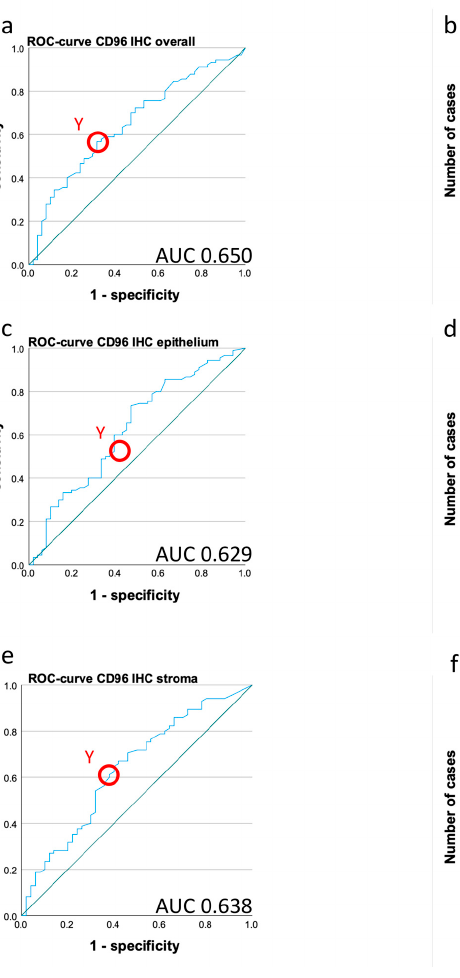
Figure 4. Determination of a cut-off point and allocation of individual cases to a group (controls vs. OSCC patients) based on CD96 protein expression. ( a , c , e ) ROC curves for CD96 mRNA protein expression based on LI determined by immunohistochemistry (IHC). The diagrams are a plot of the sensitivity (true-positive rate) vs. 1-specificity (false-positive rate) over all possible labeling indices. The circles show the points of the highest Youden (Y) indices which are associated with the COP (patients vs. controls). The AUC value is indicated. ROC: receiver operating characteristic, COP: cut-off point, AUC: area under the curve. ( b , d , f ) Division of the test and control group (group OSCC patients and group controls) into positive and negative subgroups based on the ascertained COPs of CD96 expressed as labeling index values. Using the χ 2 test, the specimens were positively (malignant) judged if the values lay above the COP. Increased CD96 expression levels in the tissue of OSCC patients ( d , f ) compared to the healthy oral mucosa of volunteers were significant. Therefore, the COP may be a parameter allowing the allocation of the tissue sample to a group and an indication of malignancy. ( a ) ROC curve for CD96 in the complete tissue area (epithelial + stromal). ( b ) χ 2 test for CD96 protein expression in the complete tissue area (epithelial + stromal). ( c ) ROC curve for CD96 in the epithelial tissue compartment. ( d ) χ 2 test for CD96 protein expression in the epithelial tissue compartment. ( e ) OC curve for CD96 in the stromal tissue compartment. ( f ) χ 2 test for CD96 protein expression in the stromal tissue